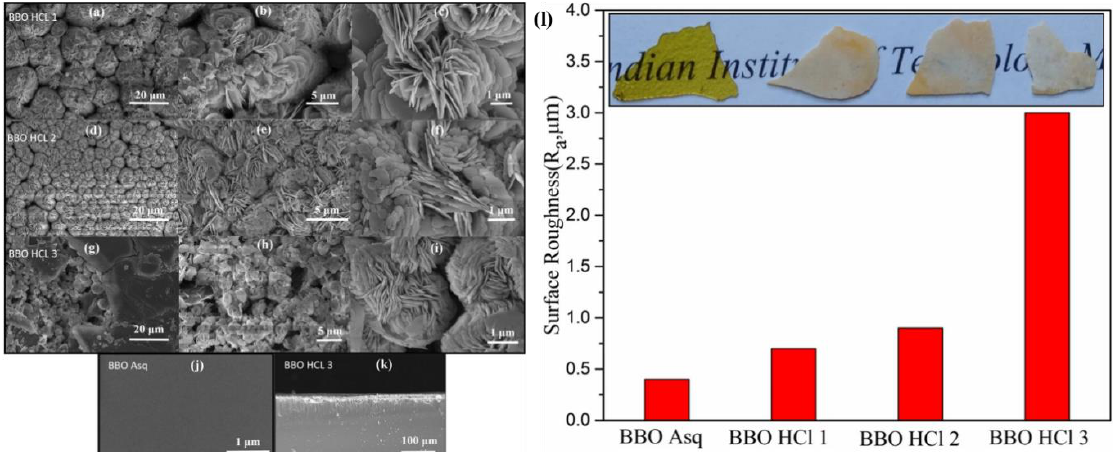
Figure 13. SEM images of ( a – i ) BBO HCl etching samples, ( j ) BBO as-quenched samples and ( k ) a typical cross-sectional image of the BBO HCl 3. ( l ) Surface roughness and images of BBO glass samples. Reprinted with permission from Ref. [113].